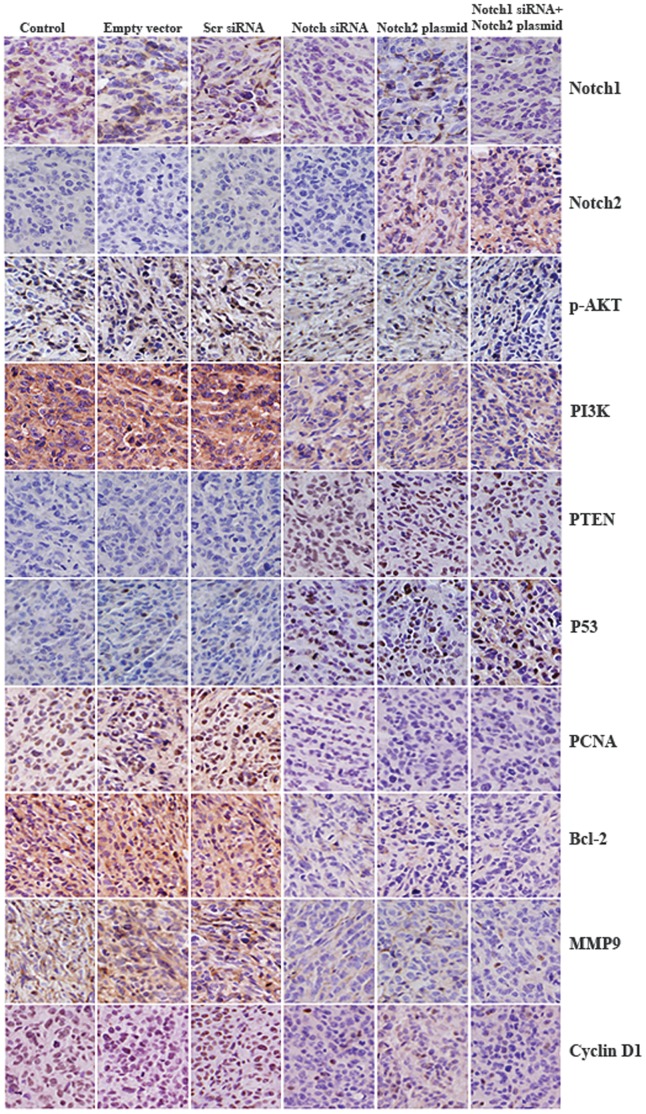
Expression of EGFR/PI3K/AKT pathway relative genes in xenograft tumors was detected by Immunohistochemistry.The expression of Notch1, PCNA, P53, MMP9, PI3K, p-AKT, Bcl-2 and Cyclin D1 in Notch1 siRNA,Notch2 construct and those two plus group treated mice treated tumors compared with that in control, scr-siRNA and empty vector treated tumors (×200).